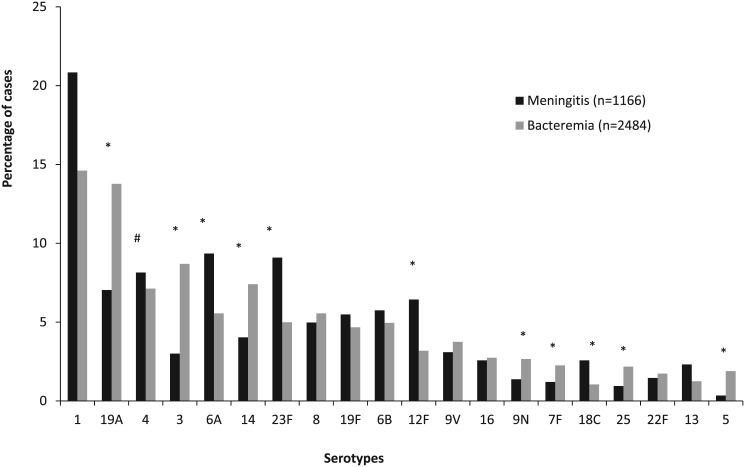
Distribution of pneumococcal serotypes amongst patients aged ≥15 years with invasive pneumococcal disease (IPD) in South Africa from 2003–2008, by clinical syndrome.# Reference group. *Statistically significant at p<0.05